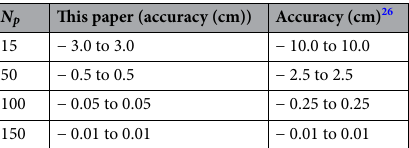
Table 2. Comparison of Euclidean distance accuracy among MS and SS numerical methods.